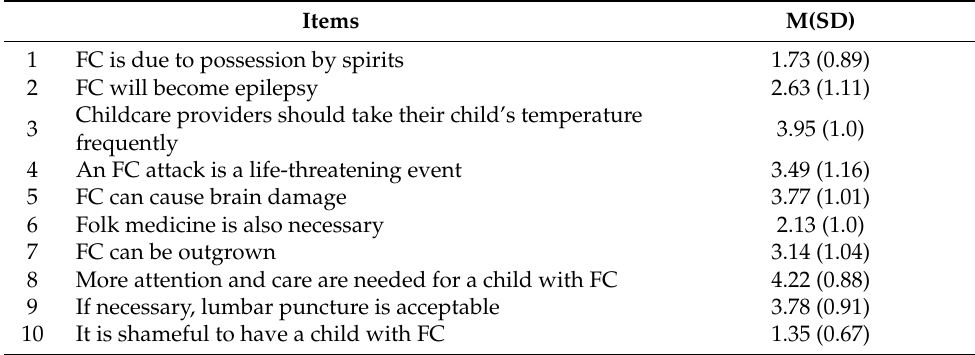
Table A3. Mean Scores of Items of Childcare Providers’ Attitude toward FC attack ( n =